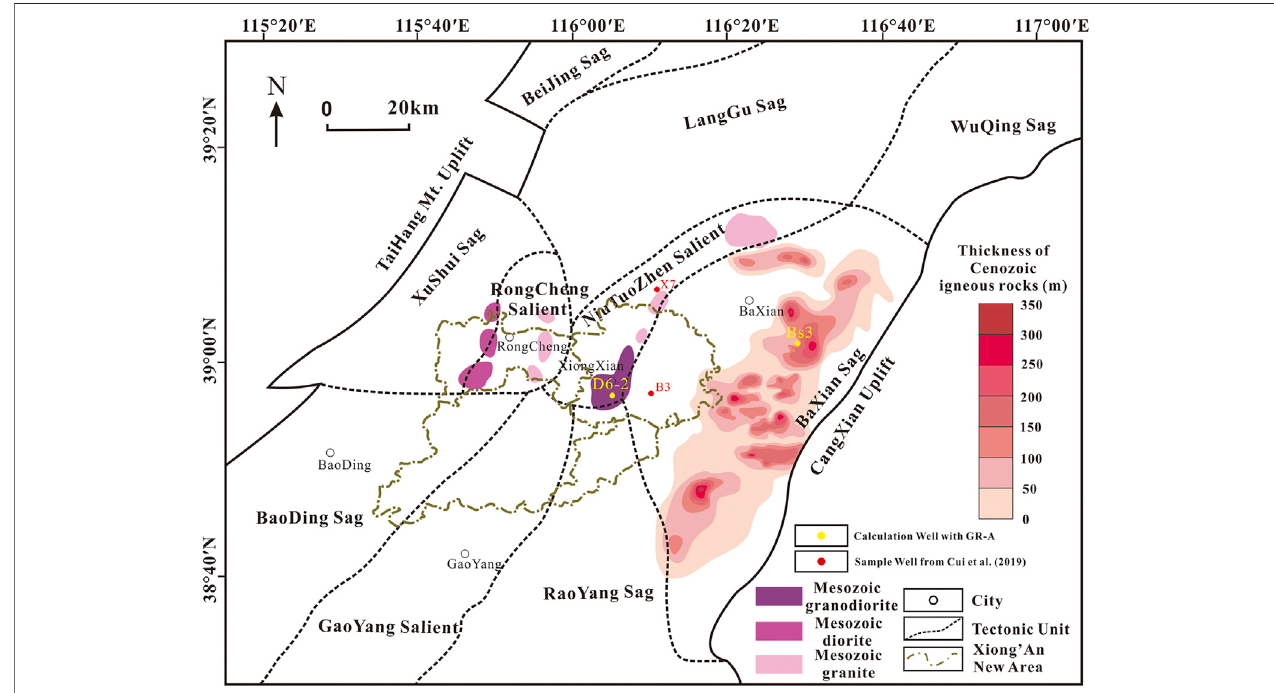
FIGURE 7 | Spatiotemporal distribution of igneous rocks in Xiong ’ an new area and the thickness of igneous rock in Baxian sag.